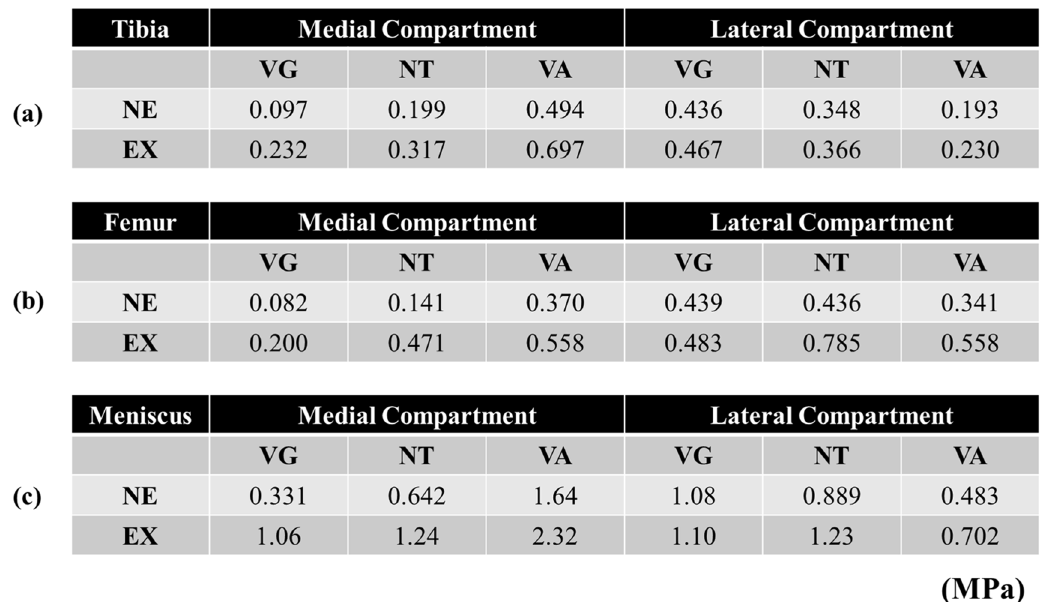
Table 3 Von mises stress on each compartment of the knee